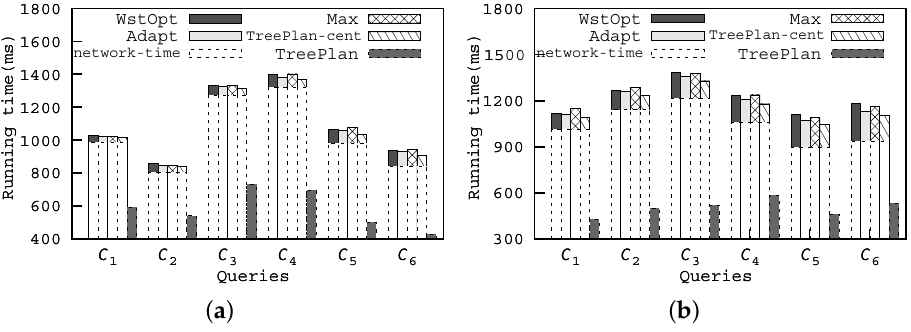
Figure 6. Performance comparison of different algorithms. ( a ) Source Codes. ( b )